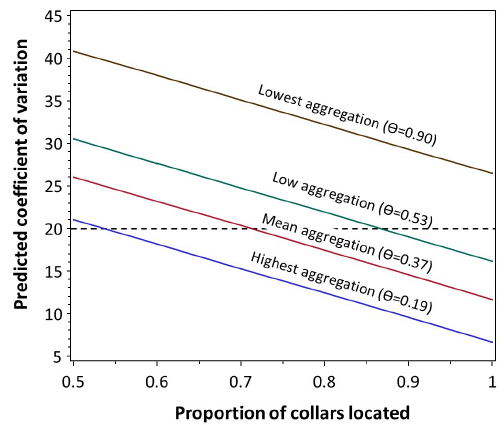
Figure 5. Predicted levels of precision as a function of roportion of available collars located across highest observed level of aggregation ( =0.19), mean levels of aggregation ( =0.37), lower levels of aggregation θ (90th percentile of =0.53) and the lowest level of ag- θ gregation ( =0.9) from regression analyses (Table 3) θ for caribou herds in Northwest Territories and Nun- θ avut, Canada, 2000-2015.